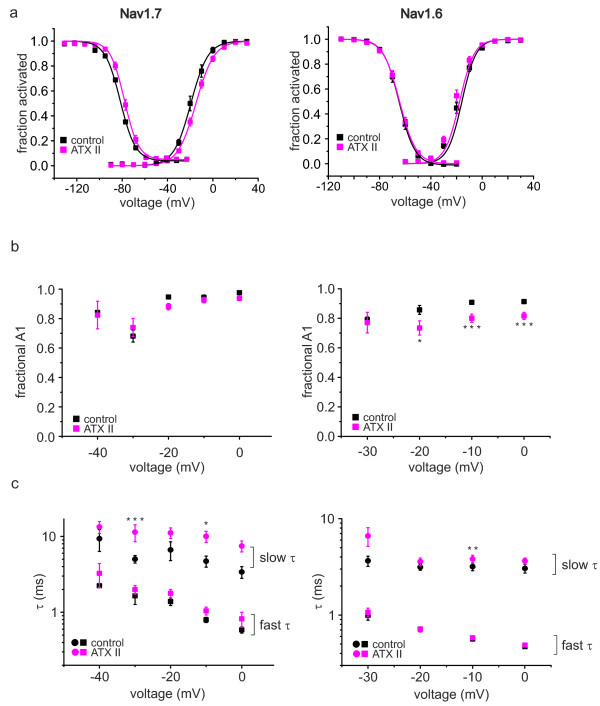
ATX-II prolongs slow time constant of inactivation of Nav1.7 and Nav1.6. (a) Voltage-dependence of activation and steady-state fast inactivation of heterologously expressed Nav1.7 (left, control n = 8, ATX-II n = 22) and Nav1.6 (right, n = 17), both recorded with the beta4 peptide in the pipette. For results of Boltzmann-fits see text. (b) and (c): Results from a double exponential fit to current decay of traces evoked by the activation protocol from cells expressing Nav1.7 (left, n = 4-22) or Nav1.6 (right, n = 7–17). (b) Fractional A1 (A1/(A1 + A2)) is shown as a function of voltage. (c) Fast and slow time constants τ of current decay are shown as a function of voltage. In both channel subtypes (Nav1.7 left column, Nav1.6 right column) only slow time constants (circles) are significantly prolonged, whereas fast time constants (squares) are unaffected by ATX-II. Independent-sample T-test for Nav1.7, paired-sample T-test for Nav1.6, * p < 0.05, ** p < 0.01, *** p < 0.001.